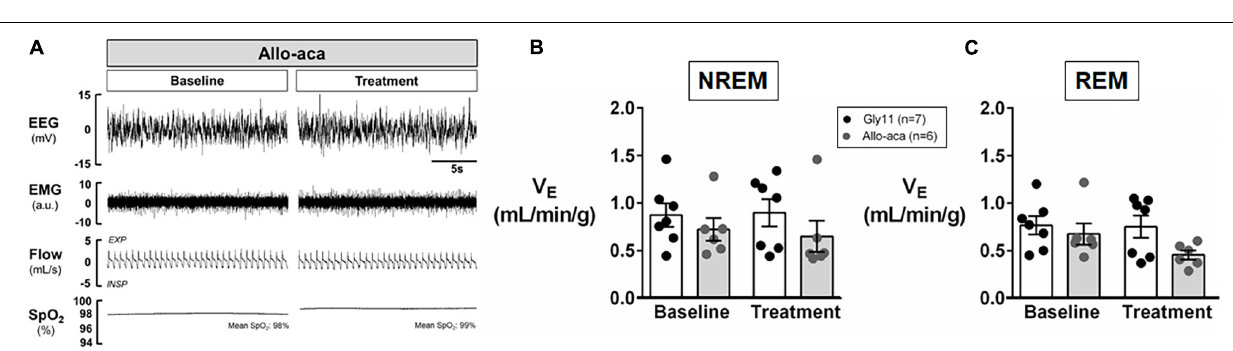
FIGURE 5 | Leptin receptor blocker Allo-aca did not exacerbate sleep-disordered breathing in NZO mice. (A) Representative trace of NREM sleep at baseline and after the treatment with leptin receptor blocker Allo-aca. Minute ventilation (V E ) was not significantly affected with either Allo-aca or control peptide compared to baseline during (B) NREM and (C) REM sleep. Mice treated with Allo-aca had a decreased V E during REM sleep than controls after treatment, but no significant interaction was observed. Data were normalized by body weight. Mean values ± standard errors are shown. Mixed regression